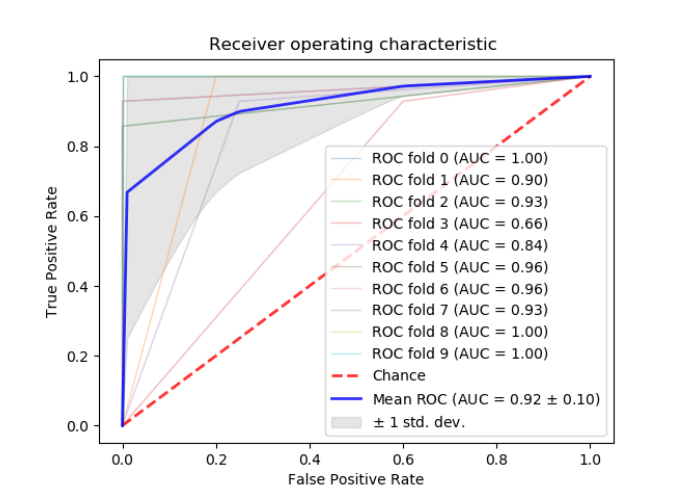
Figure 12. ROC curve using the gradient boosting classifier to separate Triple Negative Breast Cancer (TNBC) from the rest of the breast cancer subtypes. Table 8. Accuracy comparison for all classifiers, using all 253 features, the 5-miRNA signature found by the proposed approach, and the 31-miRNA signature from Romero et al. for separating triple-negative from the rest of the BRCA subtypes. 5 Feats. 253 Feats. Romero et al. (31